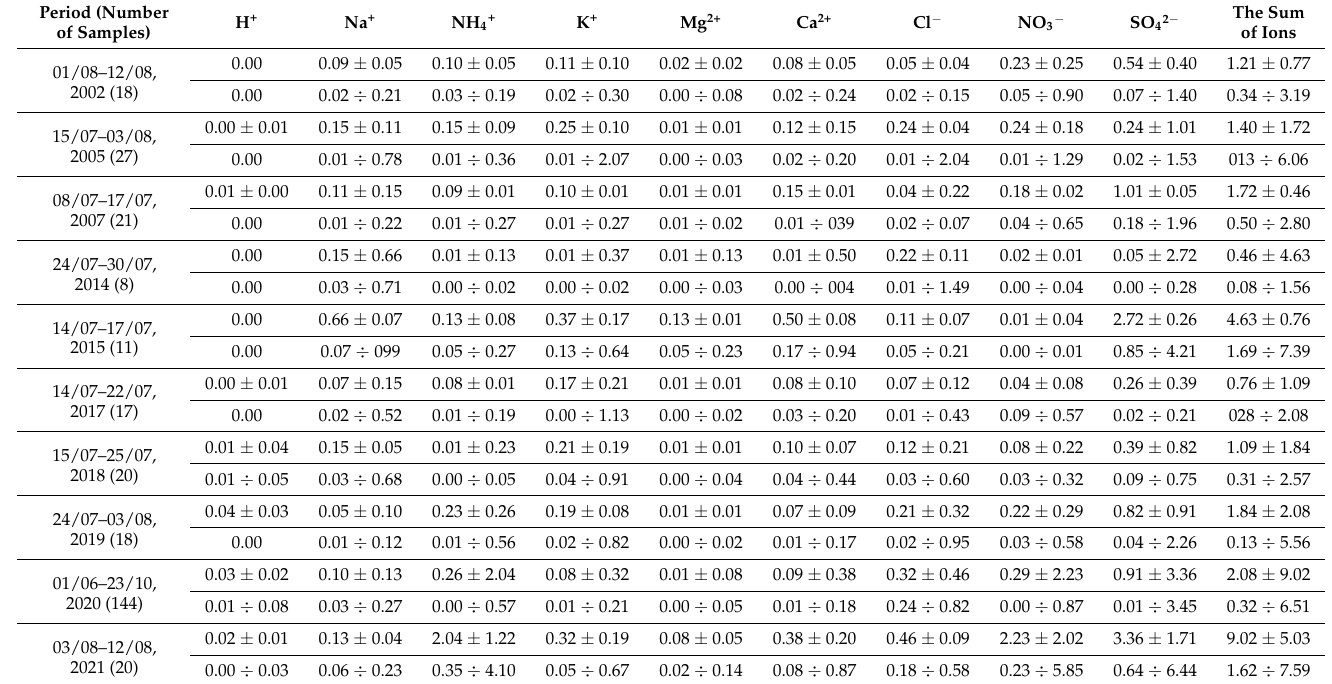
Table 4. Ionic composition of the atmospheric aerosol at the Bolshiye Koty research station from 2002 to 2021, µ g/m 3 (the upper line shows the arithmetic mean ± standard deviation; the lower line shows the